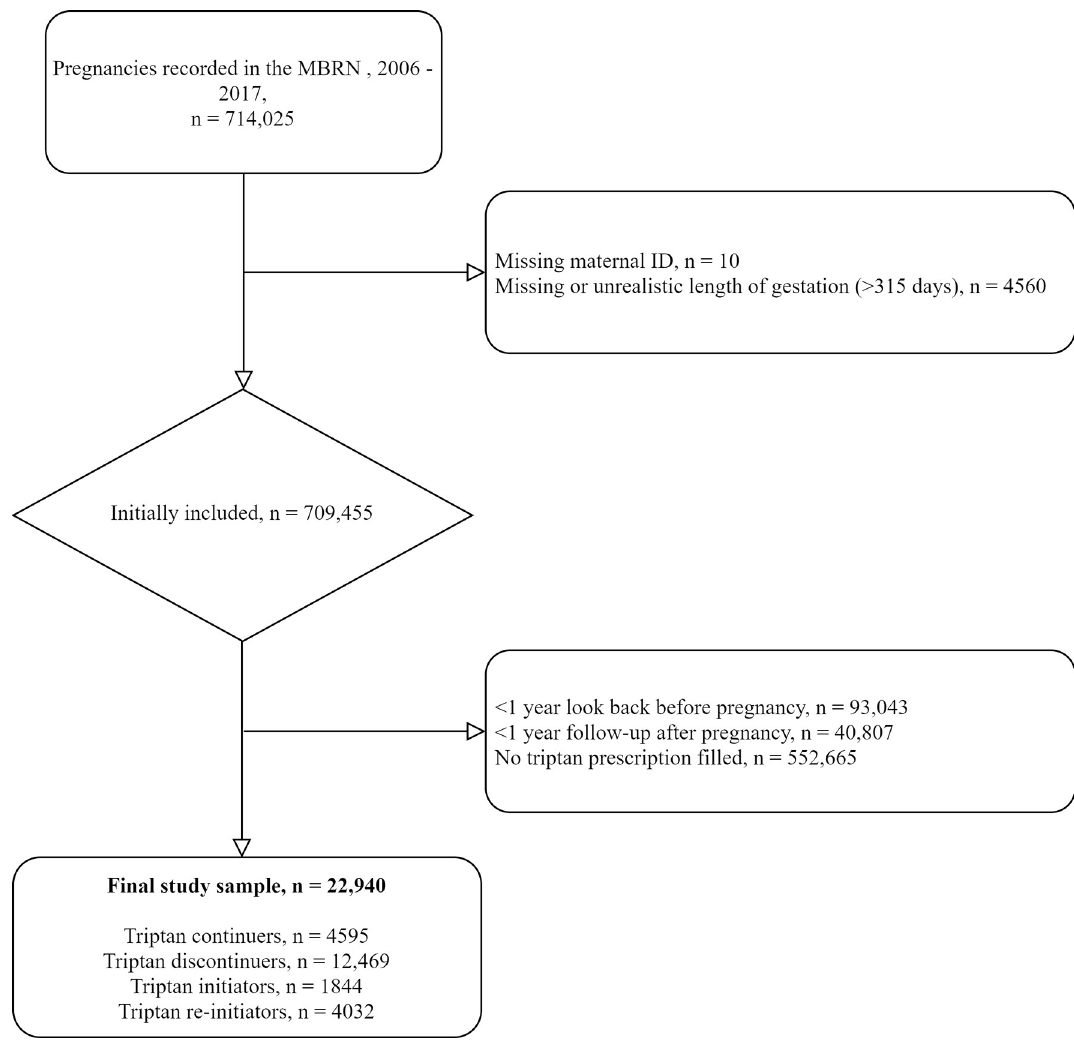
Fig 1. Flowchart of study inclusions and